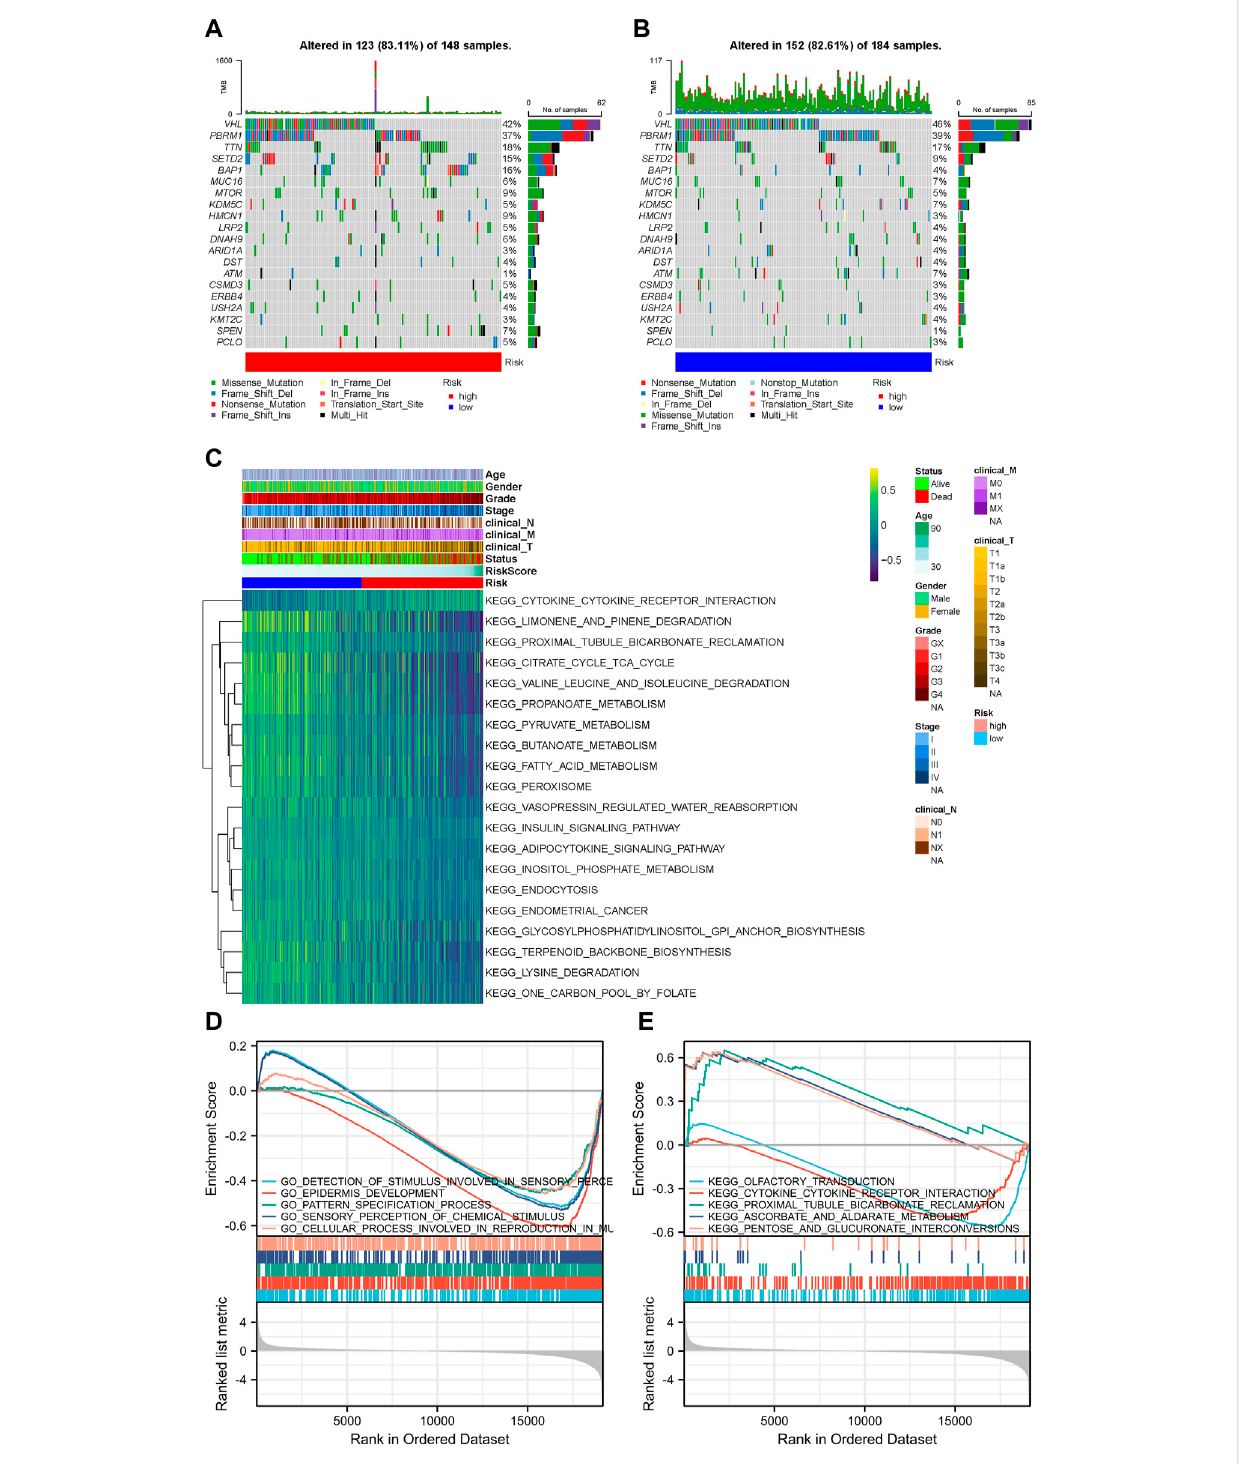
FIGURE 4 Landscape of mutation pro fi les and pathway enrichment between patients with high and low-risk clear cell renal cell carcinoma (ccRCC). Waterfall plots representing mutation information in each sample for (A) high- and (B) low-risk groups. (C) Heatmap of KEGG analysis based on risk scores in the TCGA-KIRC dataset. GSEA analysis for (D) GO biological process and (E) KEGG enrichment in the TCGA-KIRC dataset according to risk score.